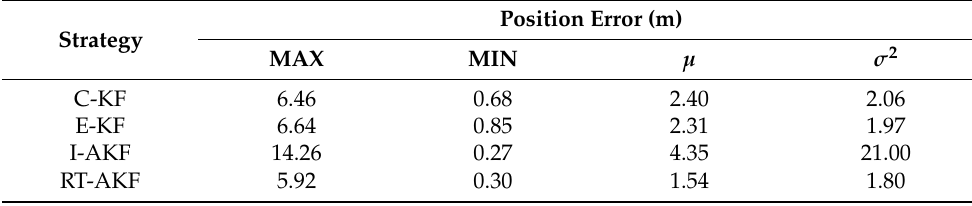
Table 5. Position Error Comparison Using Different Algorithm in Segment